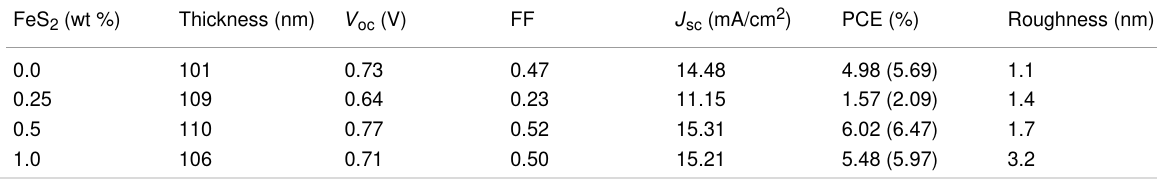
Table 1: Average PV parameters of three OPV sets with different FeS 2 content in the active layer. Concerning the PCE, the numbers in parenthesis are the best values obtained. FeS 2 (wt